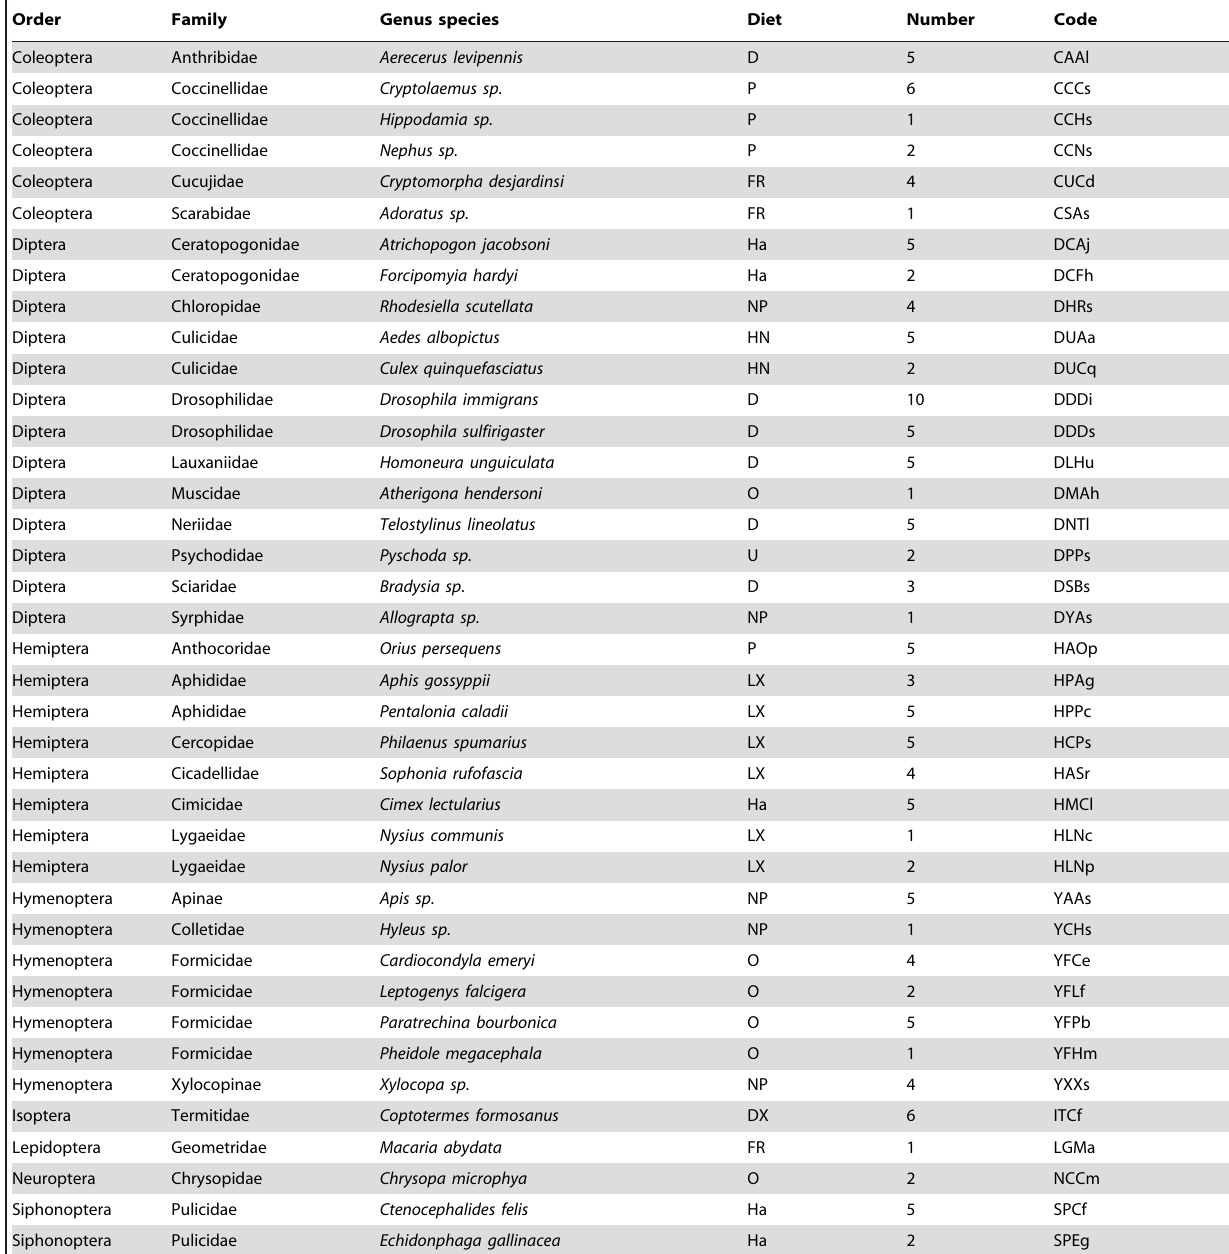
Table 1. List of insect